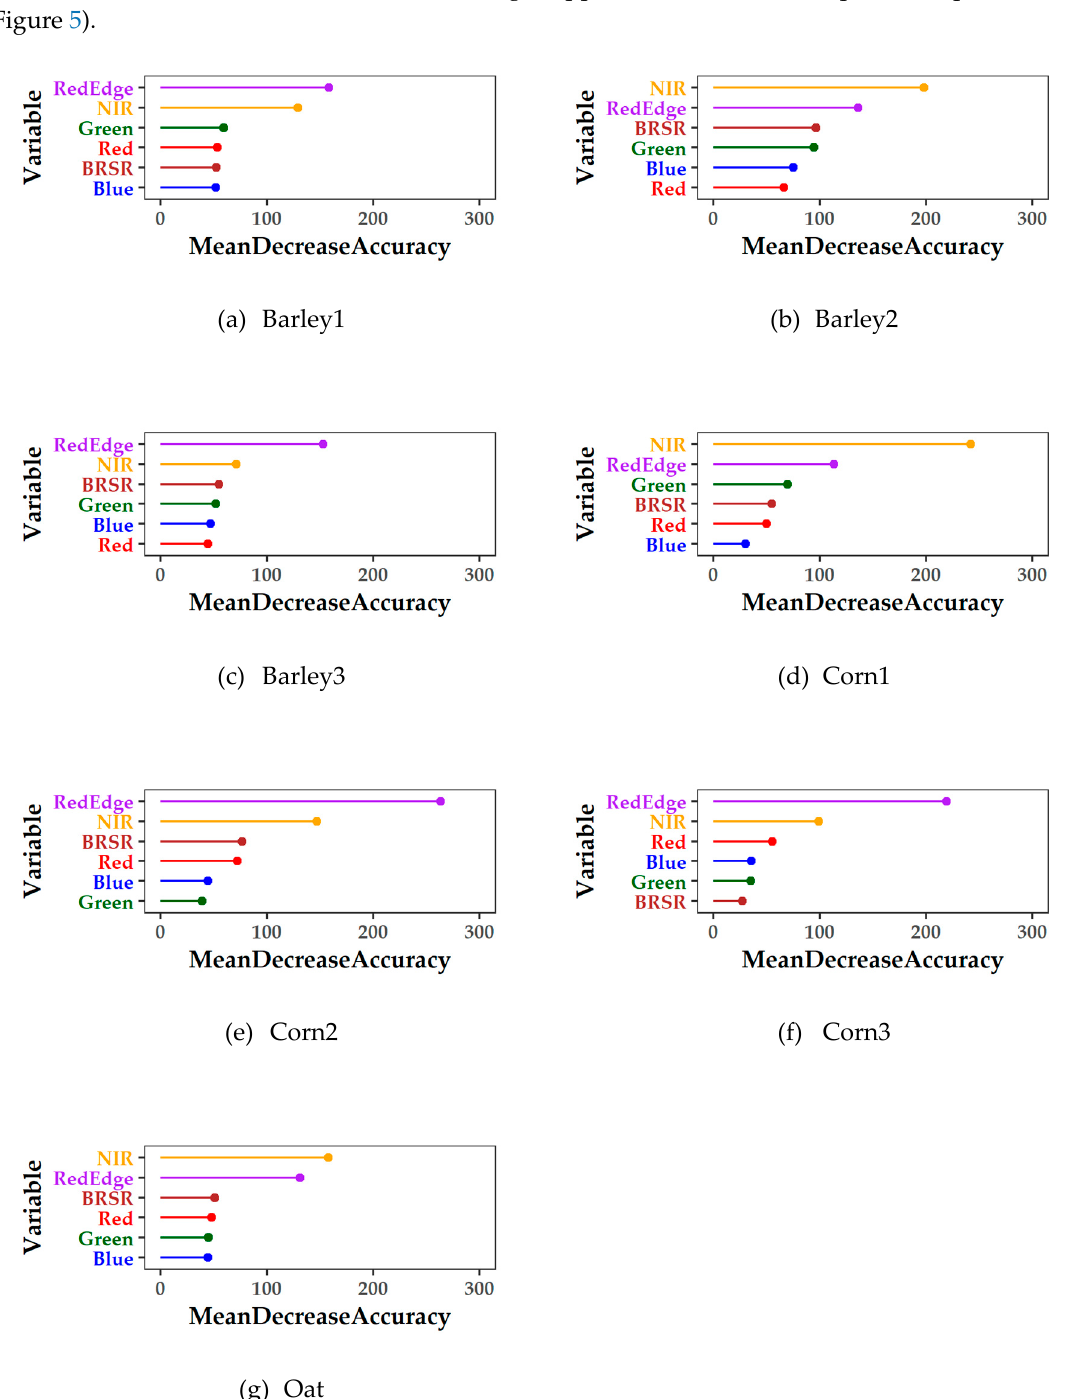
Figure 4. Variable importance plot from the pixel-based image analysis random forest classifier for the following fields: ( a ) Barley1; ( b ) Barley2; ( c ) Barley3; ( d ) Corn1; ( e ) Corn2; ( f ) Corn3; ( g ) Oat.